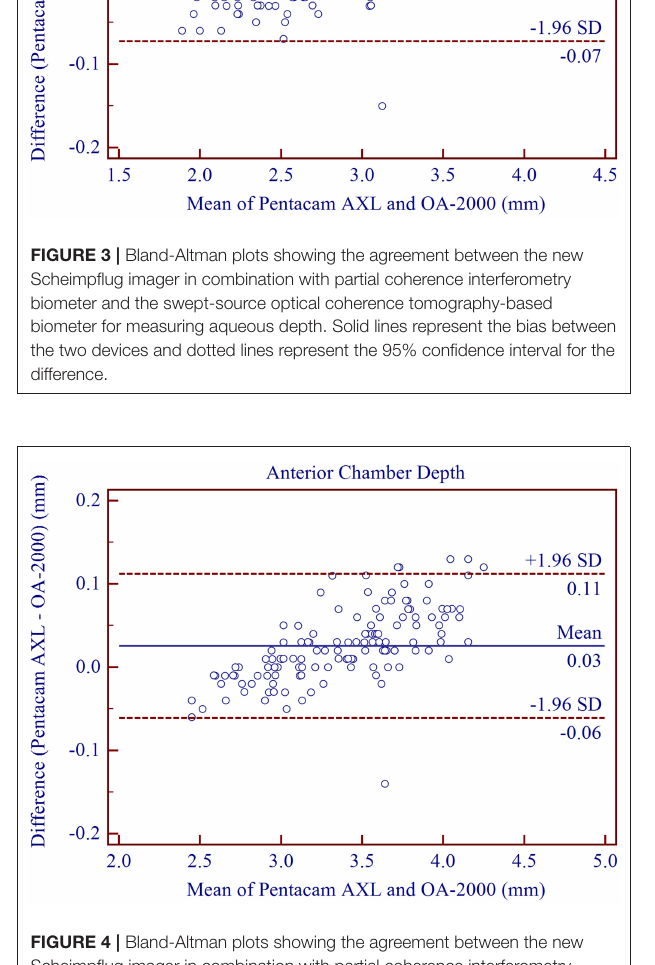
FIGURE 4 | Bland-Altman plots showing the agreement between the new Scheimpflug imager in combination with partial coherence interferometry biometer and the swept-source optical coherence tomography-based biometer for measuring anterior chamber depth. Solid lines represent the bias between the two devices and dotted lines represent the 95% confidence interval for the difference.